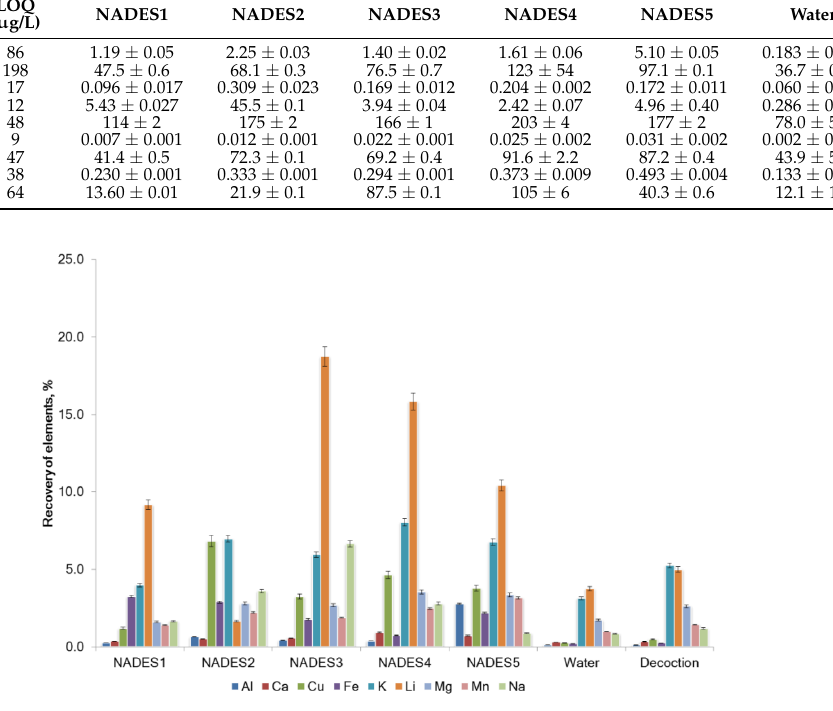
Figure 2. Recovery of the elements from G. glabra using NADES and water.